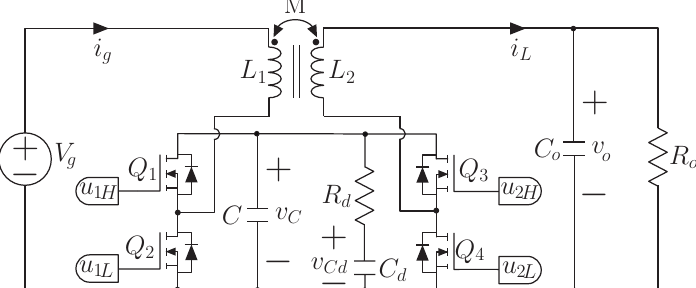
Figure 2. Power stage of a coupled-inductor buck-boost converter.